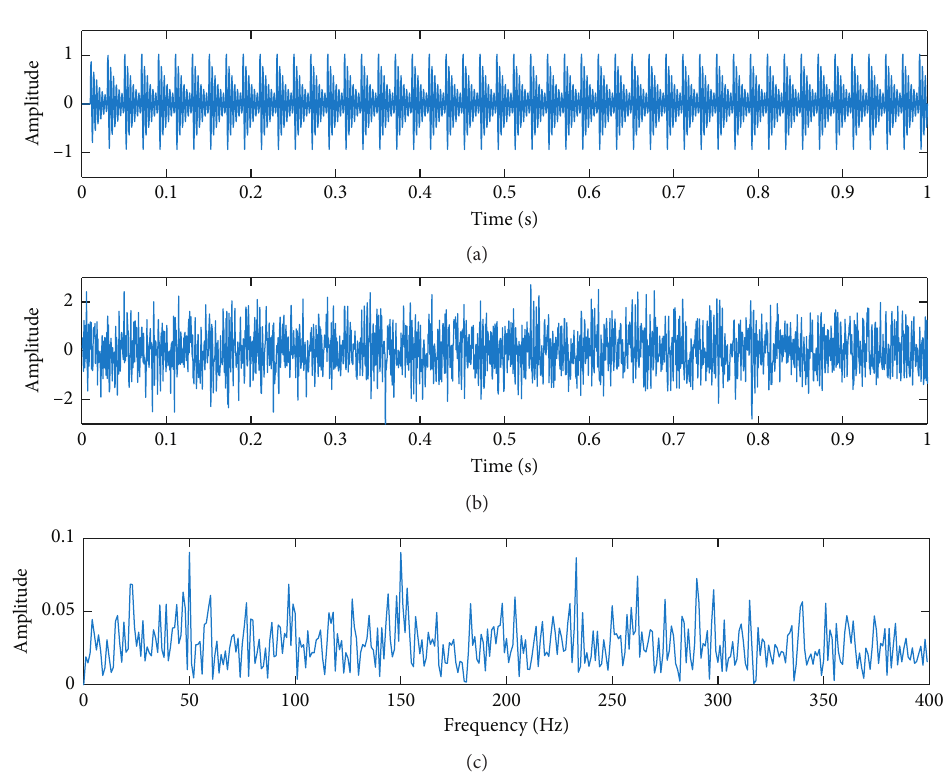
Figure 2: The wave of simulated signal (SNR � − 5 dB): (a) pure signal x ( t ) , (b) noisy signal y ( t ) , (c) envelope spectrum.